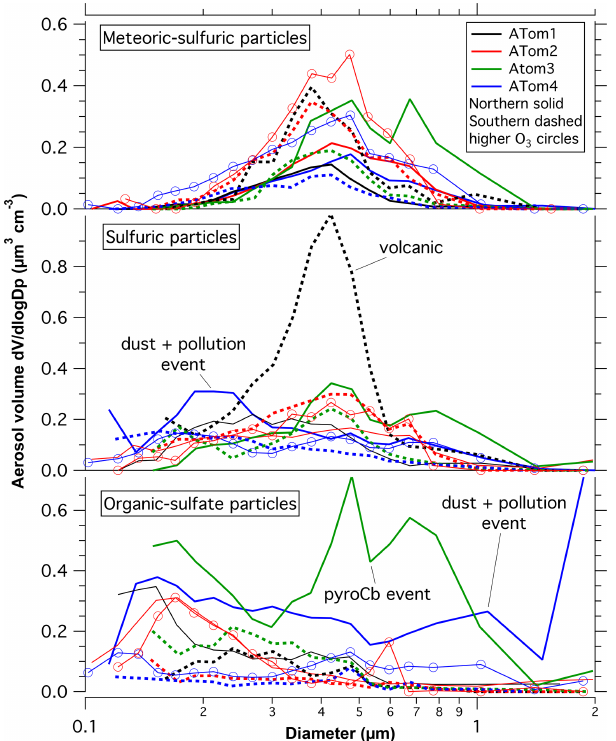
Figure 4. Size distributions of several types of particles in the lower stratosphere. Northern Hemisphere data are solid, and Southern Hemisphere data are dashed. Data are from 250 to 400ppbv ozone except the curves with circles, the data of which are at more than 500ppbv ozone. The three major events are noted where they may have influenced the size distributions. Lognormal fits are given in Table 1.